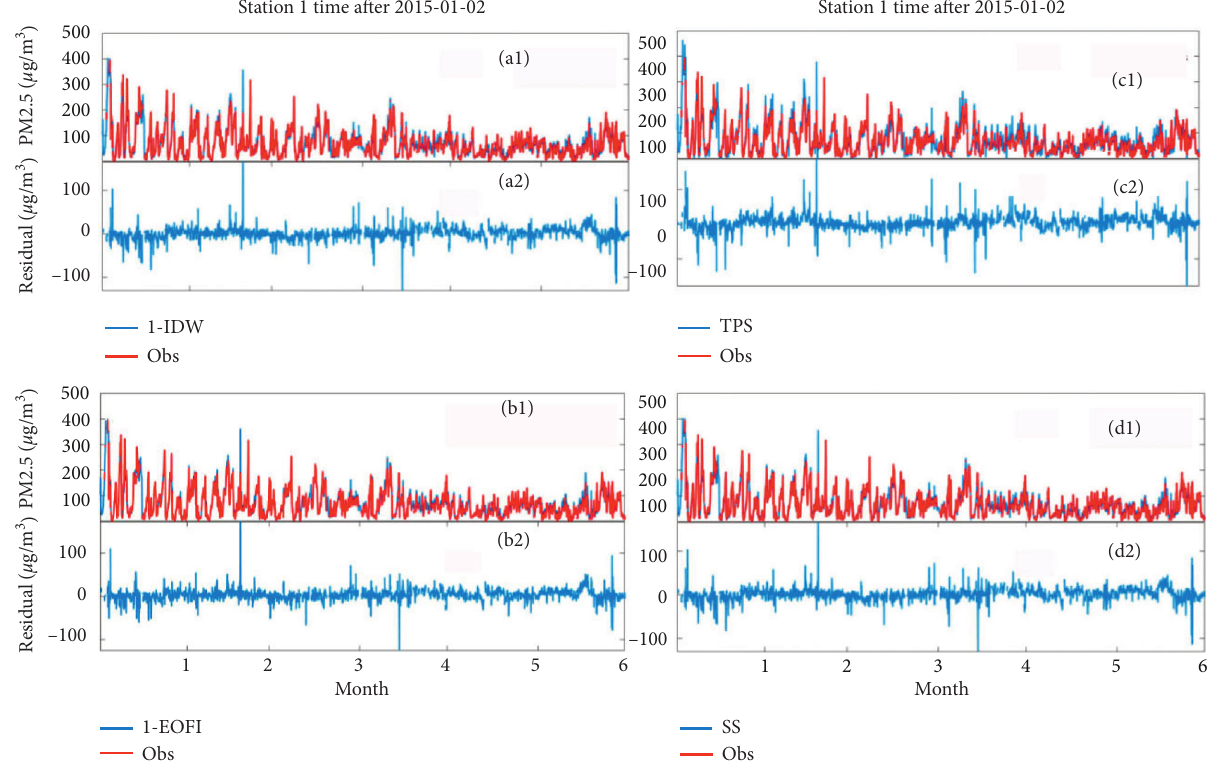
Figure 4: 1-IDW (a1),1-EOFI (b1), TPS (c1), and SS (d1) reconstruction sequence and observations in sta 1 and their corresponding residuals (a2, b2, c2, and d2), 4138 hours after 2015-01-02 1:00. The numbers in front of EOFI and IDW represent the value of their inverse distance weight P ; for example, 1-EOFI represents the value of EOFI’s inverse distance weight P is 1.